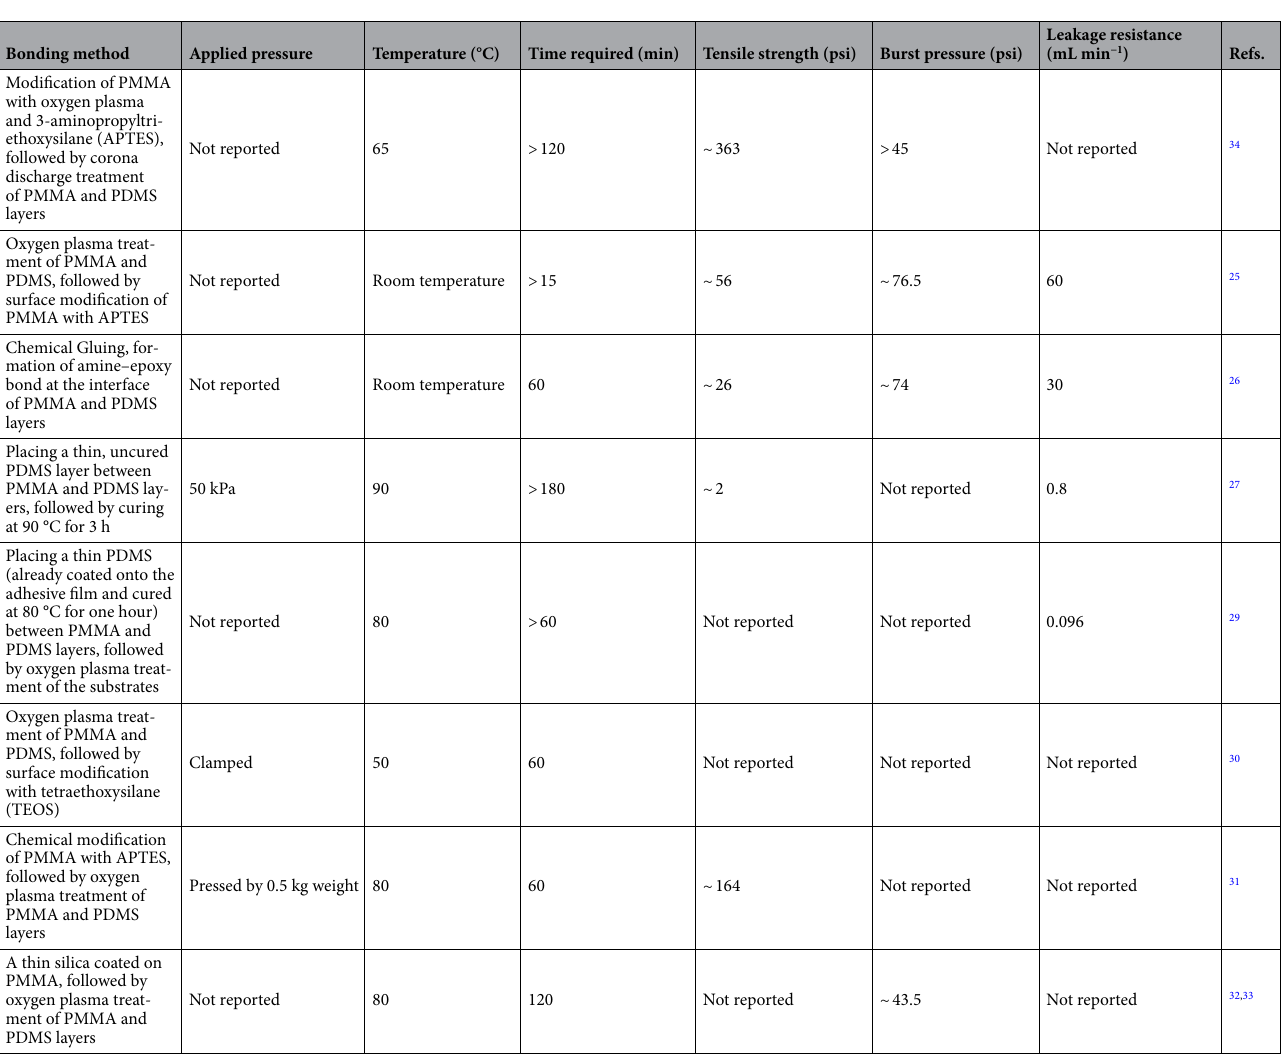
Table 1. Comparison of various methods developed for bonding PMMA and PDMS